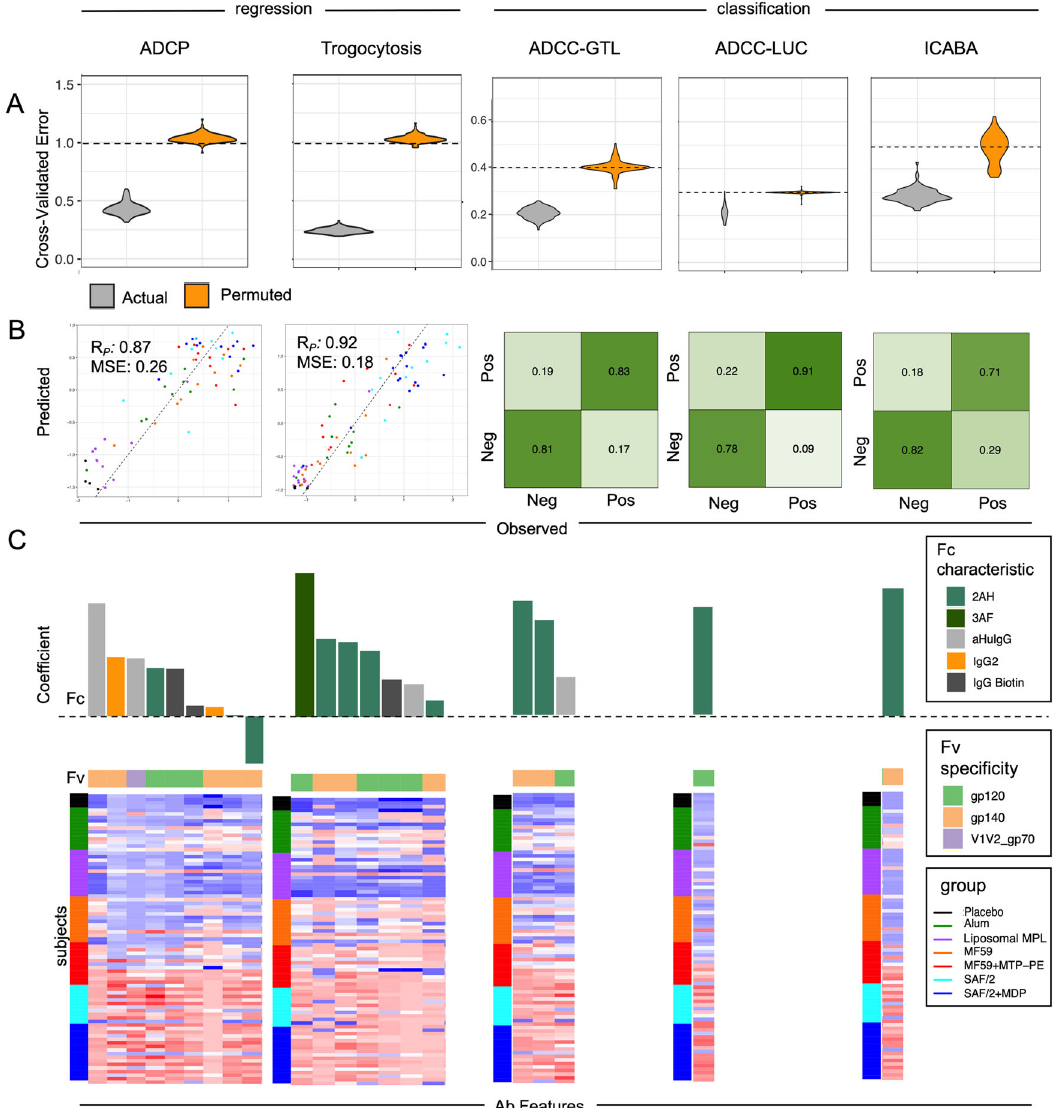
Fig. 6 Predictions of antibody functions based on biophysical features. A Mean cross-validated error observed in predicting diverse antibody functions as continuous variables (regression, left) or by class (high/low activity classi fi cation, right). Performance of repeated modeling of actual study data is shown in gray violin plots. Predictive repeated modeling of permuted activity magnitudes (ADCP, trogocytosis) or class labels (ADCC-GTL, ADCC-LUC, ICABA) is shown in orange violin plots, and performance does not overlap with modeling of actual data, p -values < 0.01. The mean error expected at random is indicated by dotted lines. B Performance of the fi nal model for different functional outcomes as de fi ned by Pearson correlation coef fi cient (R P ) and mean squared error (MSE) for (ADCP, trogocytosis) or by confusion matrix (ADCC ADCC-GTL, ADCC-LUC, ICABA) between predicted and observed activity. C Features contributing to models of antibody function. In the bar chart at top, features are arranged by the magnitude and direction of their coef fi cients (top), with Fc characteristic indicated in color, and the Fv speci fi city of each feature shown in the color bar below. The dotted line indicates a coef fi cient of zero. In the heatmap at the bottom, responses observed across vaccine recipients in each study group are shown for each feature (column) contributing the model. Subjects (rows) are grouped by adjuvant. High responses are shown in red, and low responses in blue. 2AH indicates binding to Fc γ RIIAH, and 3AF indicates binding to Fc γ point to the need to carefully assess the effect of particular adjuvant and antigen formulations in humans. In the AVEG015 trial, MF59-adjuvanted immunization raised responses that were qualitatively similar in both biophysical and functional character to that of alum. Variable functional responses have been seen with MF59 in NHP HIV vaccination models. Vaccari et al. reported that